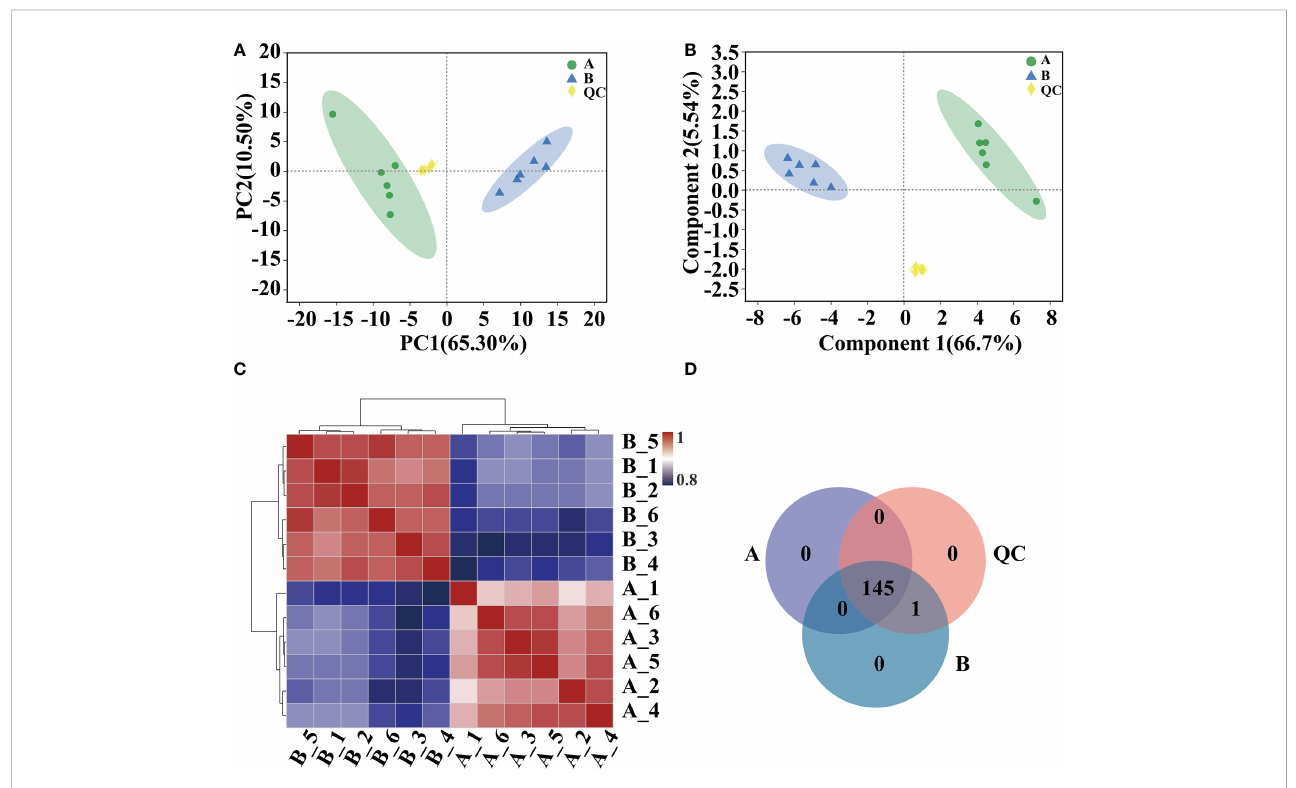
FIGURE 5 Comparative analysis of metabolic group samples. (A, B) Inter-sample metabolomic PCA and PLS-DA plots. (C) Heat map of differences between metabolic group samples. (D) Veen map of sample